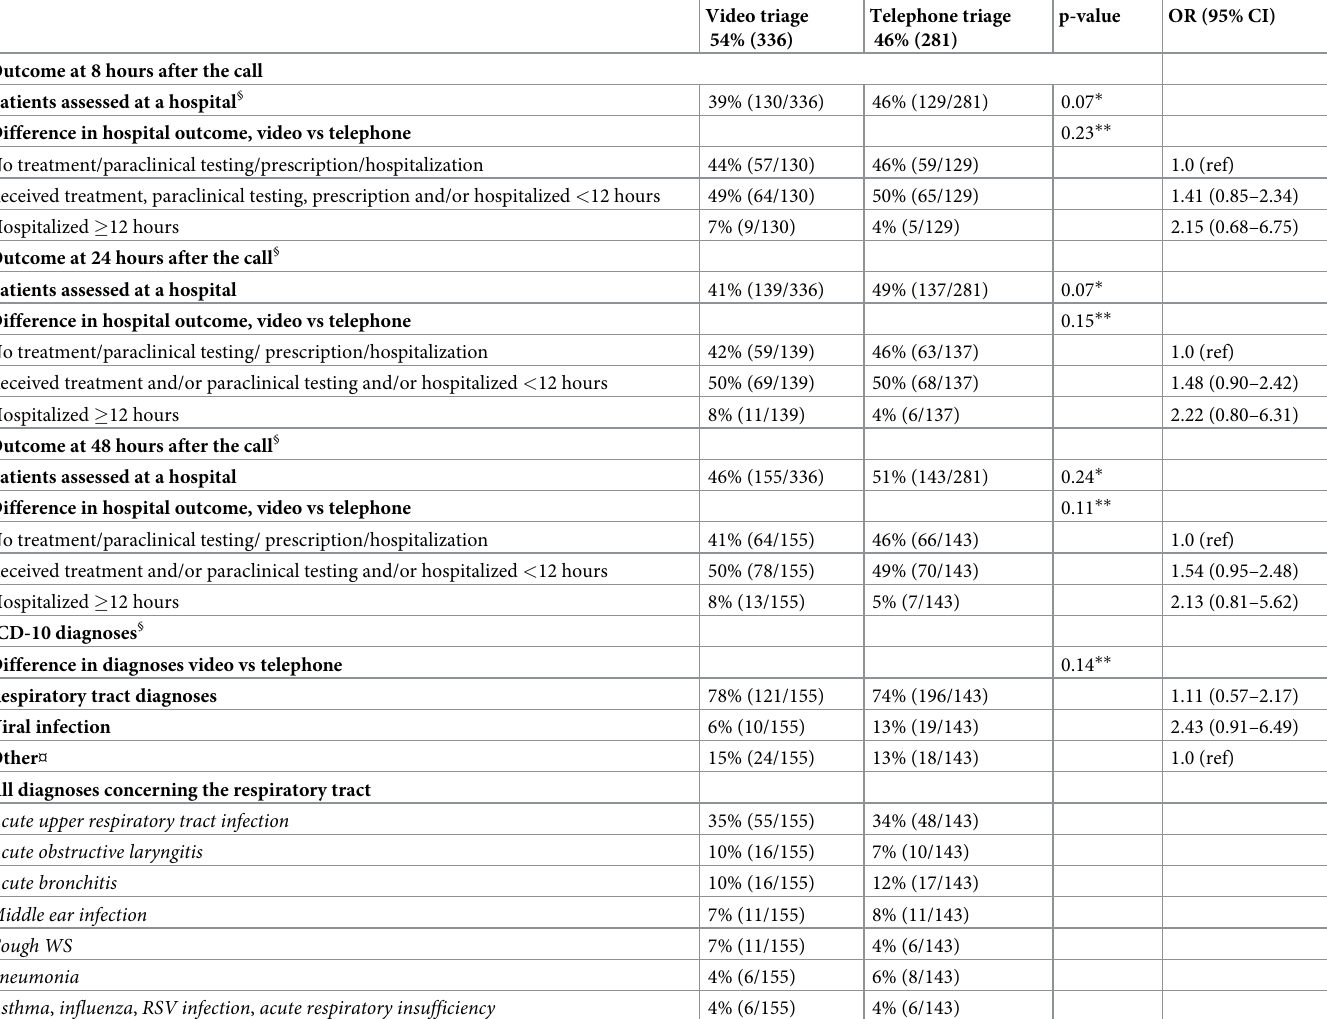
Table 2. Outcome of patients from the video and telephone triage groups assessed at hospital within 48 hours after the index